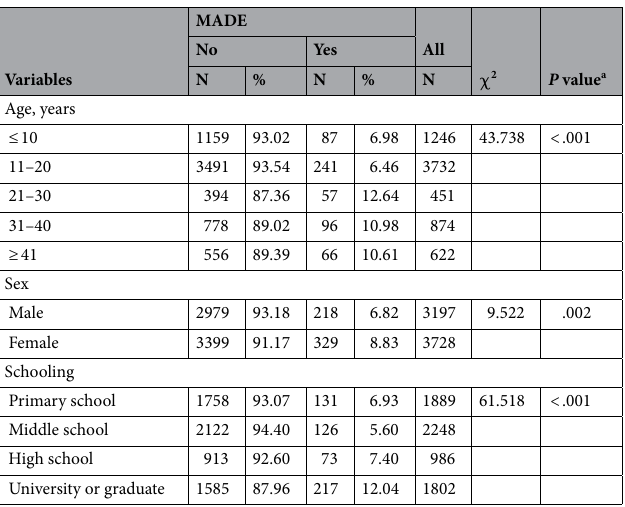
Table 2. The incidence of MADE in the study participants.